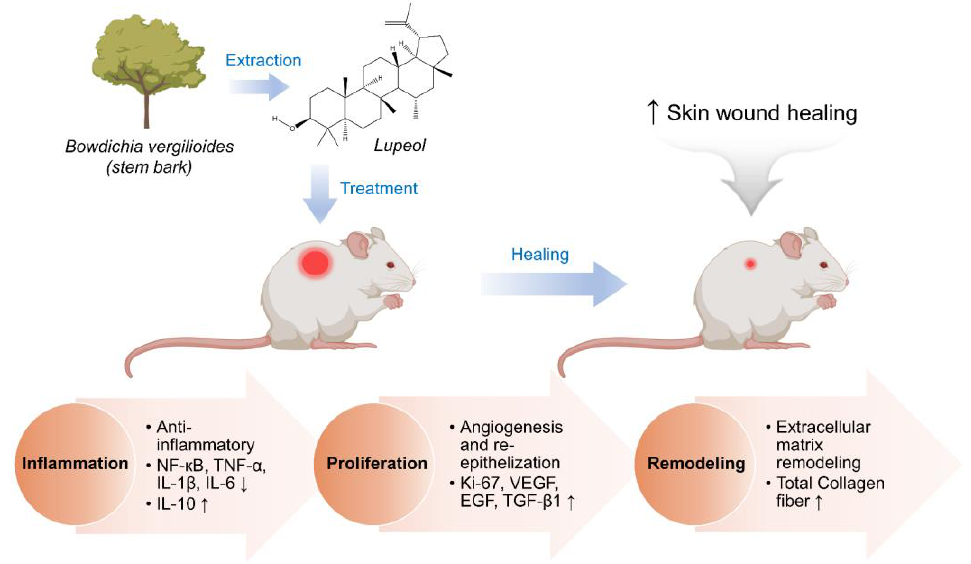
Figure 3. The effect of lupeol cream on wound healing. Up and down arrows mean increasing and decreasing of concentration, respectively. Reproduced with permission from Beserra et al., “From Inflammation to Cutaneous Repair: Topical Applica-tion of Lupeol Improves Skin Wound Healing in Rats by Modulating the Cytokine Levels, NF- κ B, Ki-67, Growth Factor Expression, and Distribution of Collagen Fibers”; published by MDPI, 2020 [58].